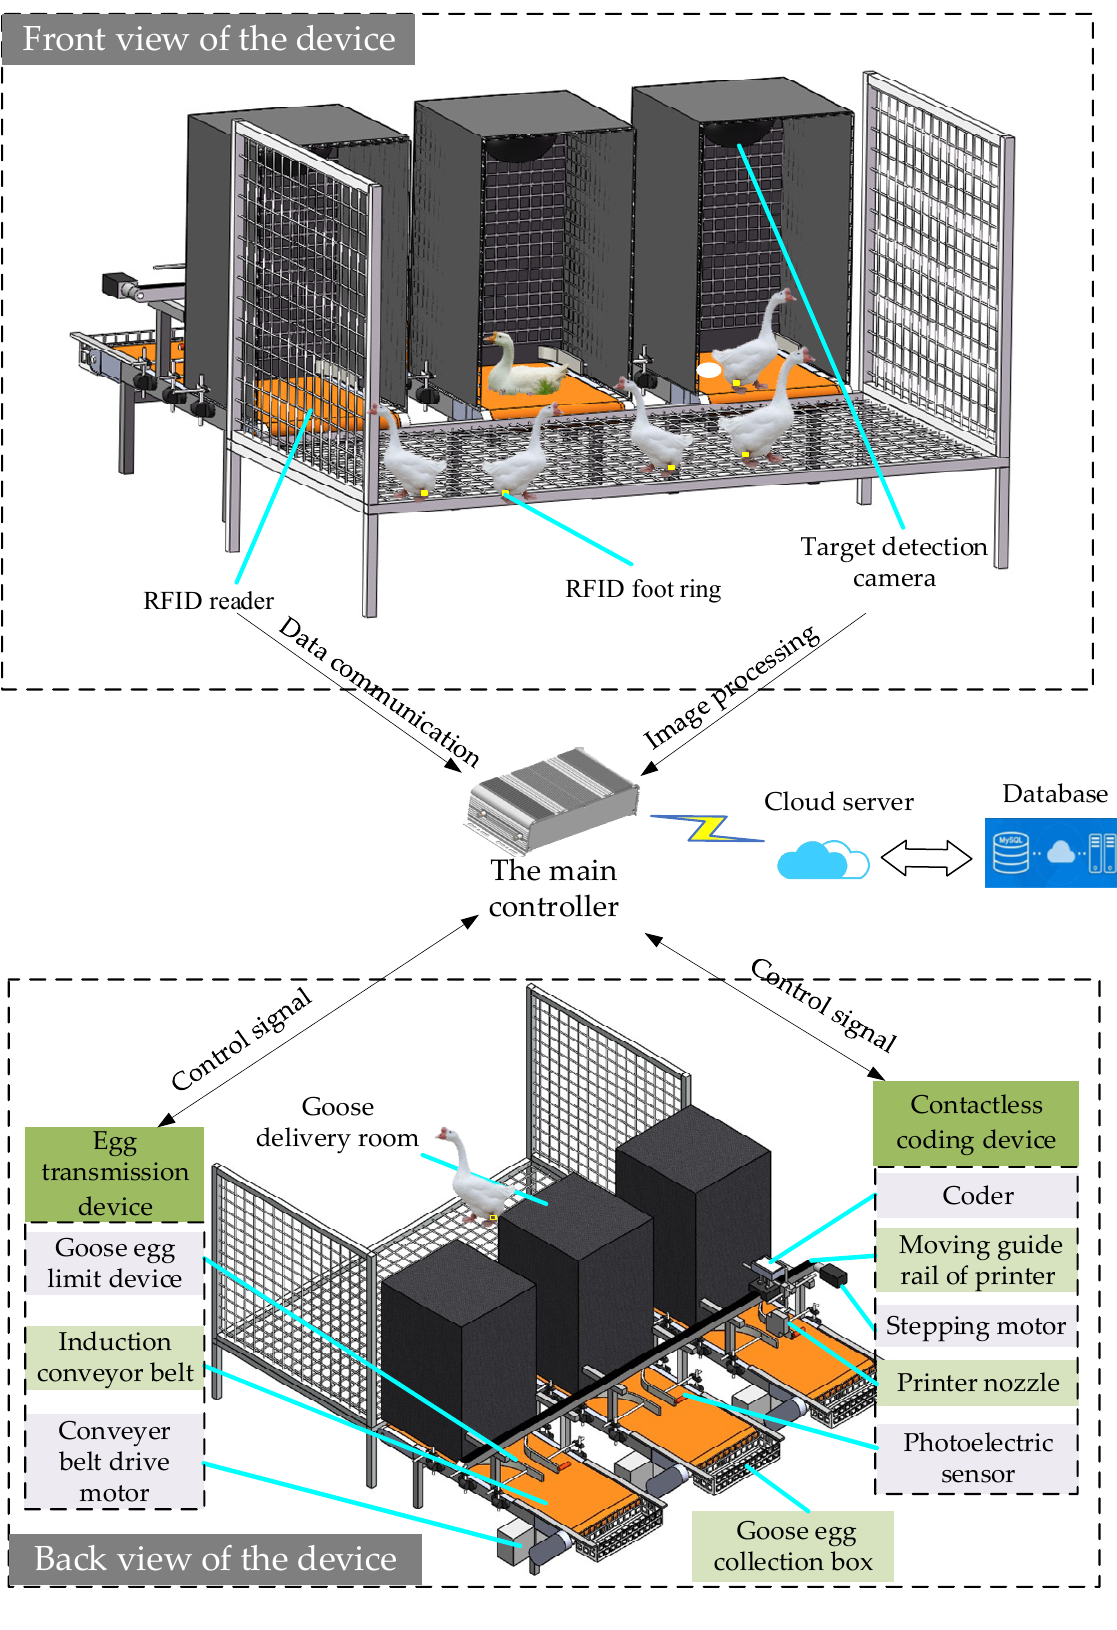
Figure 1. Operation mechanism of breeding egg identification and coding system.